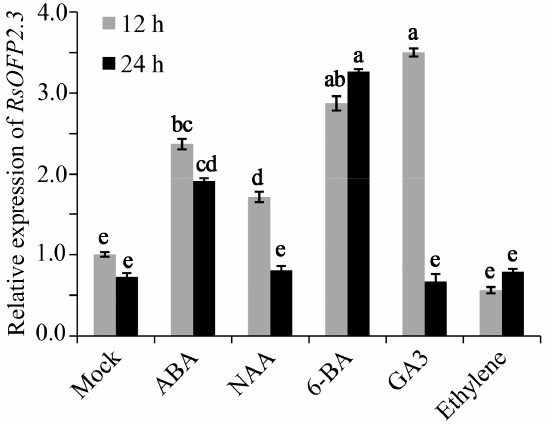
Figure 8. Responses of RsOFP2.3 to five classic hormones in seedling roots after 12 h and 24 h treatment. Error bars on each point indicate ±SE from at least three independent replicates. Different letters indicate significant differences as determined using ANOVA, followed by Tukey’s HSD test ( p < 0.05).